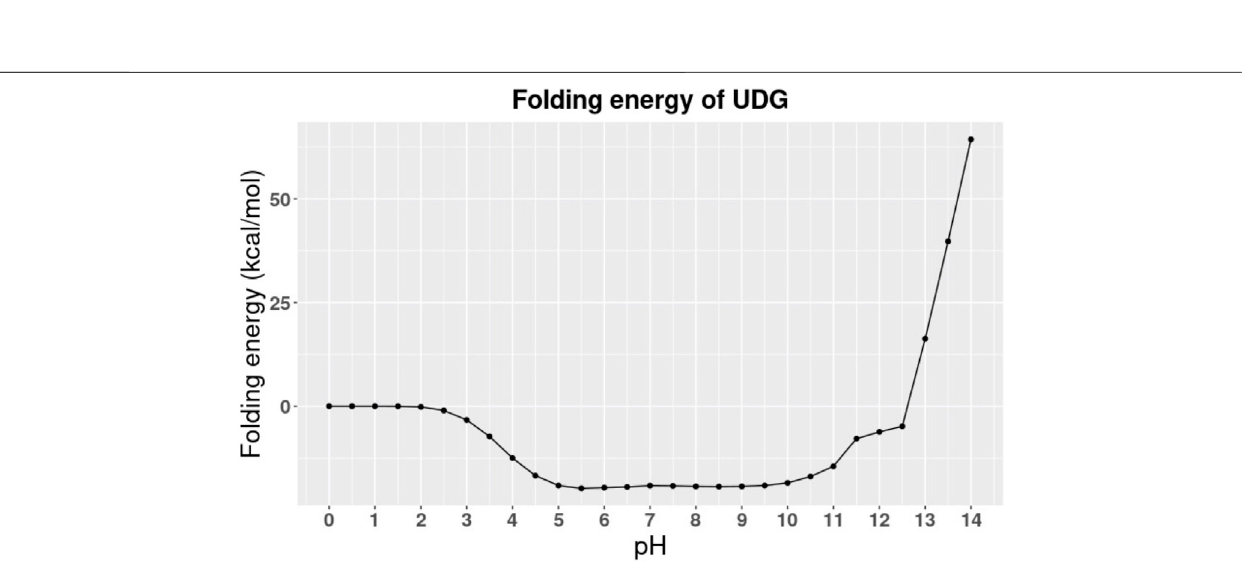
FIGURE 2 | The pH dependence of UDG ’ s folding